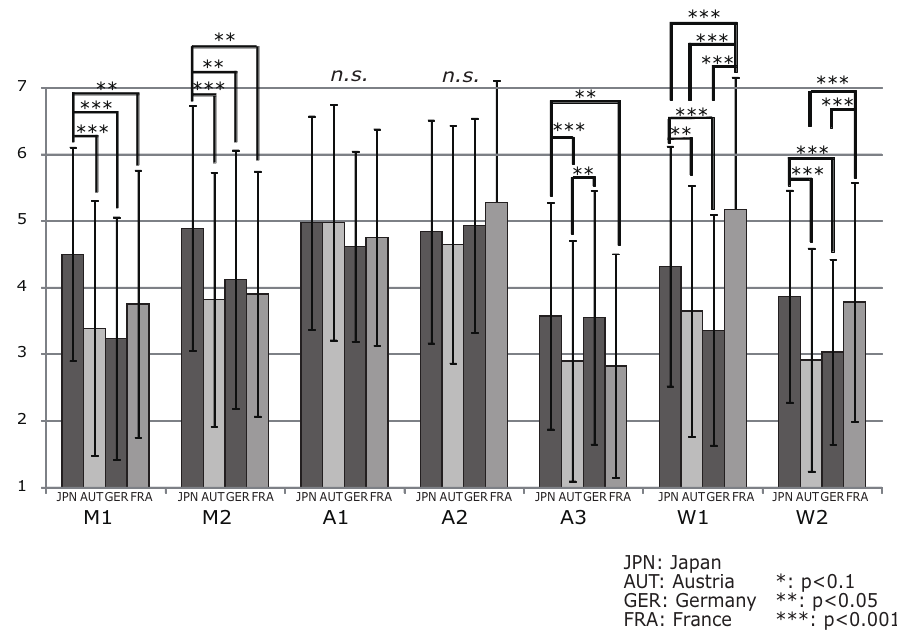
Figure 5. Scores for impressions about the android (ANOVA(Analysis of